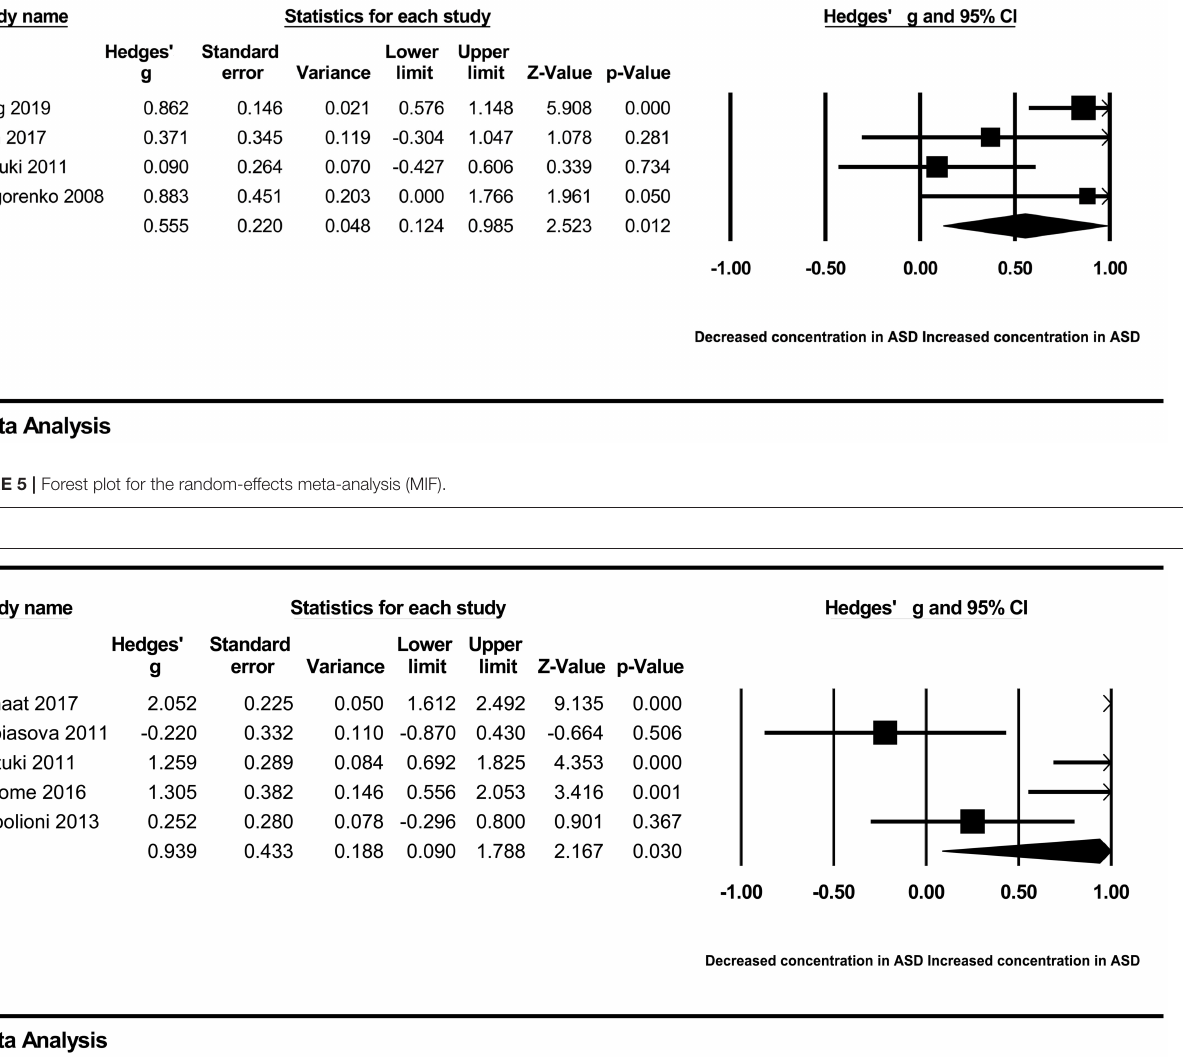
FIGURE 6 | Forest plot for the random-effects meta-analysis